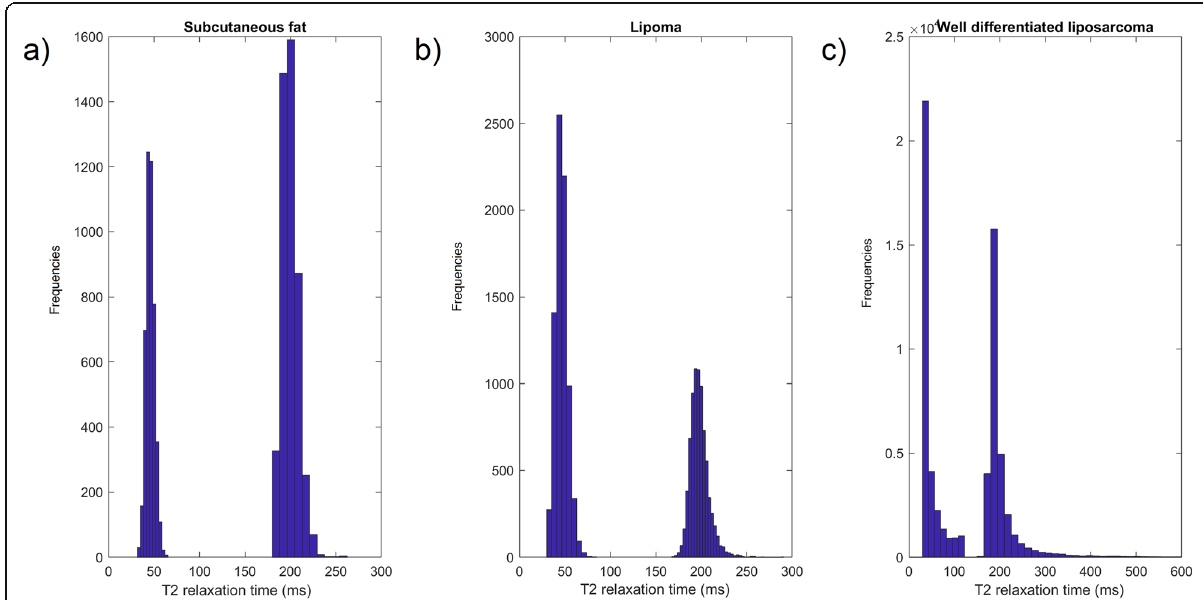
Fig. 4 Derived Mexp spectra from purely biexponential tissue samples for subcutaneous fat ( a ), lipoma ( b ), and well-differentiated liposarcoma ( c